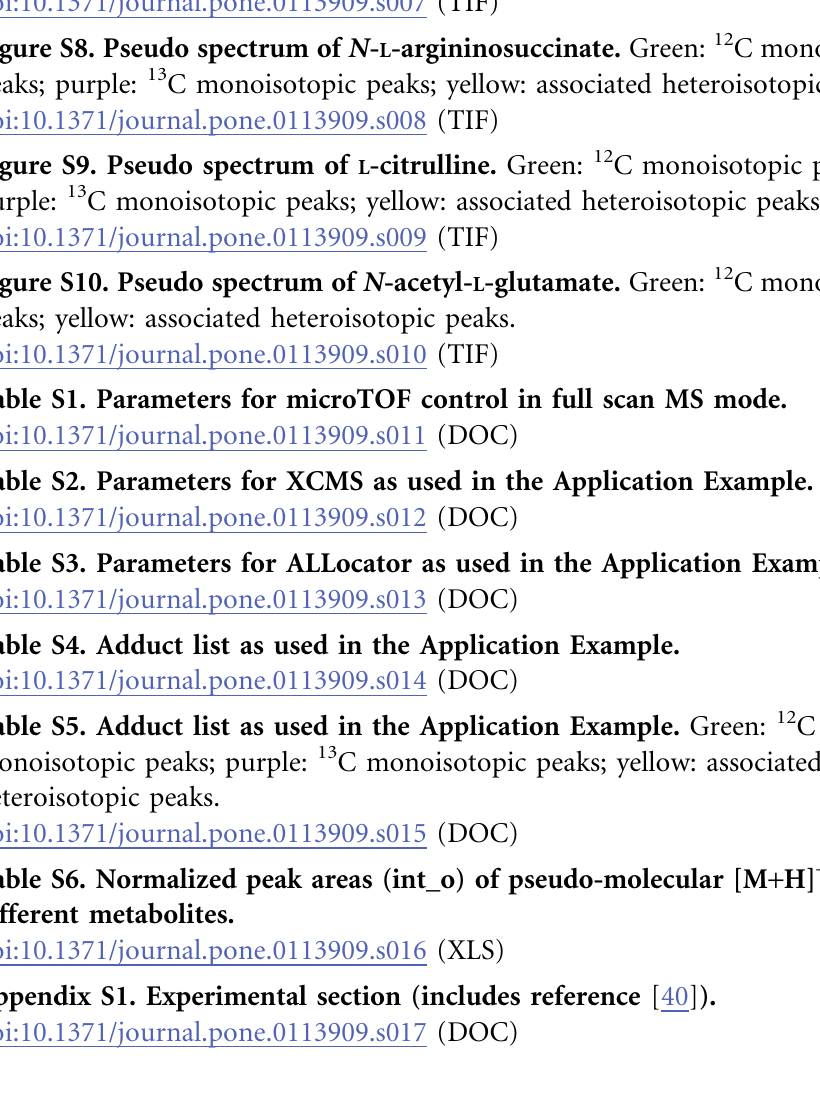
Figure S6. Pseudo spectrum of ( c -)glutamyl-valine. Green: 12 C monoisotopic peaks; purple: 13 C monoisotopic peaks; yellow: associated heteroisotopic peaks. doi:10.1371/journal.pone.0113909.s006 (TIF) Figure S7. Pseudo spectrum of L -arginine. Green: 12 C monoisotopic peaks; purple: 13 C monoisotopic peaks; yellow: associated heteroisotopic peaks. doi:10.1371/journal.pone.0113909.s007 (TIF) Figure S8. Pseudo spectrum of N - L -argininosuccinate. Green: 12 C monoisotopic peaks; purple: 13 C monoisotopic peaks; yellow: associated heteroisotopic peaks. doi:10.1371/journal.pone.0113909.s008 (TIF) Figure S9. Pseudo spectrum of L -citrulline. Green: 12 C monoisotopic peaks; purple: 13 C monoisotopic peaks; yellow: associated heteroisotopic peaks. Figure S10. Pseudo spectrum of N -acetyl- L -glutamate. Green: 12 C monoisotopic peaks; yellow: associated heteroisotopic peaks. Table S1. Parameters for microTOF control in full scan MS mode. Table S2. Parameters for XCMS as used in the Application Example. Table S3. Parameters for ALLocator as used in the Application Example. Table S4. Adduct list as used in the Application Example. Table S5. Adduct list as used in the Application Example. Green: 12 C monoisotopic peaks; purple: 13 C monoisotopic peaks; yellow: associated heteroisotopic peaks. Table S6. Normalized peak areas (int_o) of pseudo-molecular [M + H] + ions of different